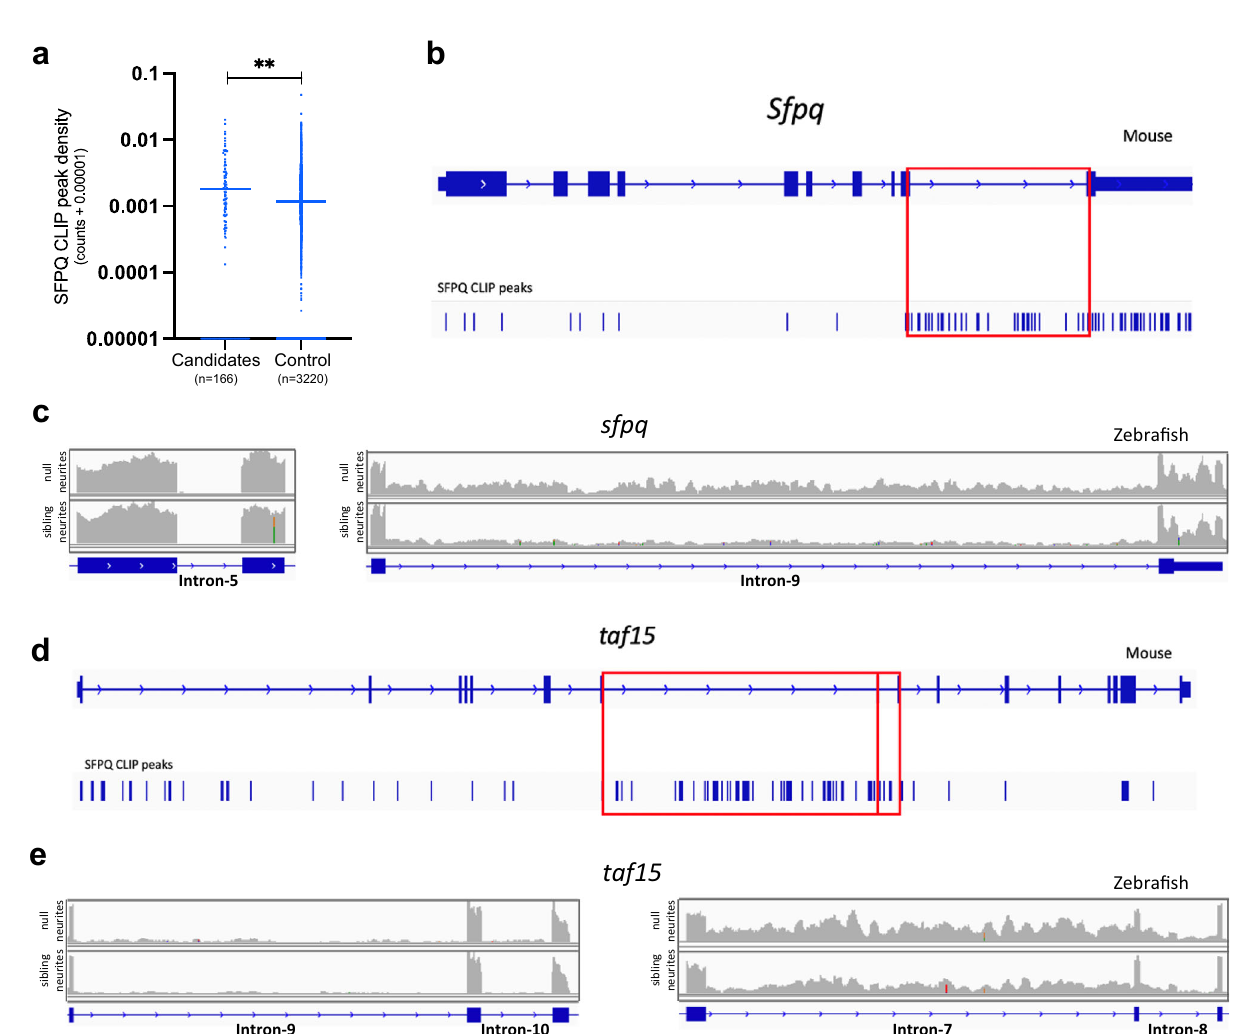
Fig. 4 | PreT-IR transcripts undergo cleavage/polyadenylation and neurite localisationinSFPQ-deprivedneurons.a CorrelationbetweenRNAseqreadslope gradient in null and number of cleavage sites in introns of sloping IR-transcripts. Two-tailed Pearson correlation coef fi cient, r: − 0.3506, p <0.0001 ( n =247 sloping IR-transcripts, FDR<0.05). b Ef fi ciency of cleavage site usage in classic (Left; ( n =107, FDR<0.05)) and sloping (Middle; ( n =37, m < − 0.1, FDR<0.05)) IR- transcripts in sibling and null samples. (Right) Ef fi ciency of cleavage site usage in retained introns between classic versus sloping IR-transcripts in null samples. Floatingbarplotswherethemiddlerepresentsthemedianandtheupperandlower limits represent the maximum and minimum values. Two-tailed Mann – Whitney tests. (Left) p =0.21, (Middle) ** p :0.0076, (Right) **** p <0.0001 ( c ) Positions of 3 ’ mRNAseq read clusters along igdcc3 in 24hpf sibling null embryo RNA samples, indicating sites of cleavage and polyadenylation. Peak height indicates relative usage of each cleavage site among transcripts of that sample. Dashed lines demarcate intron-2. Black arrows indicate peaks targeted by 3 ’ RACE. d 3 ’ RACE